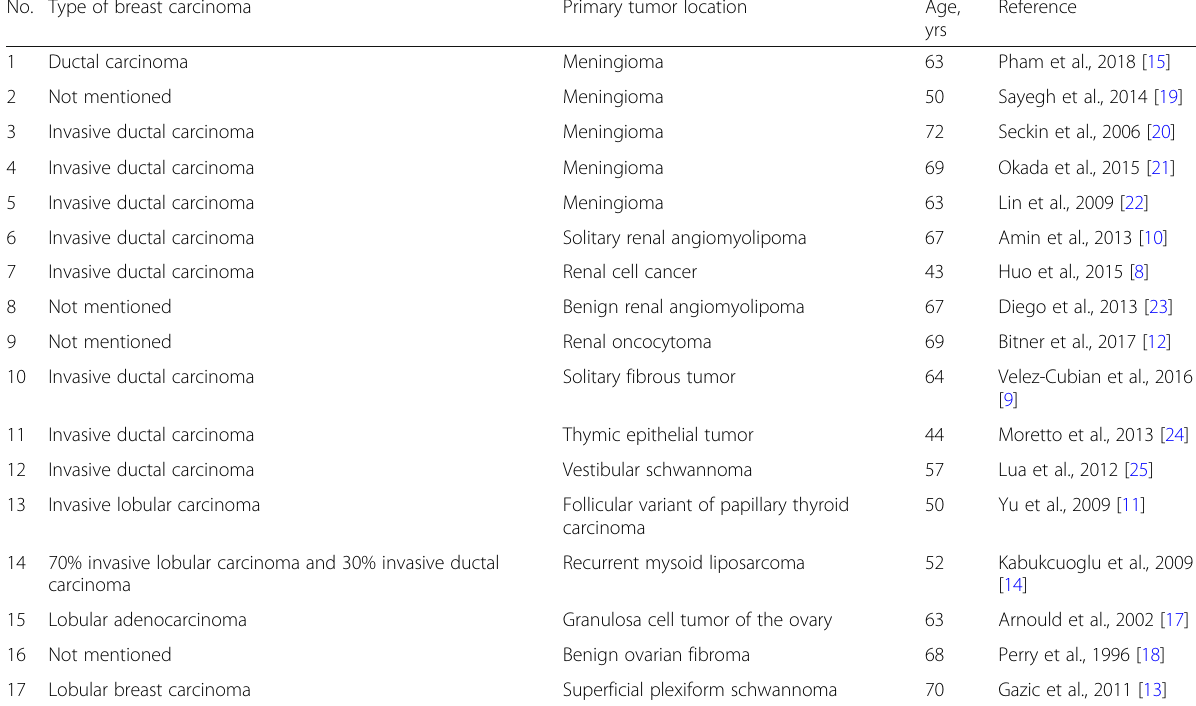
Table 1 Summary of TTM cases reported in the literature from breast